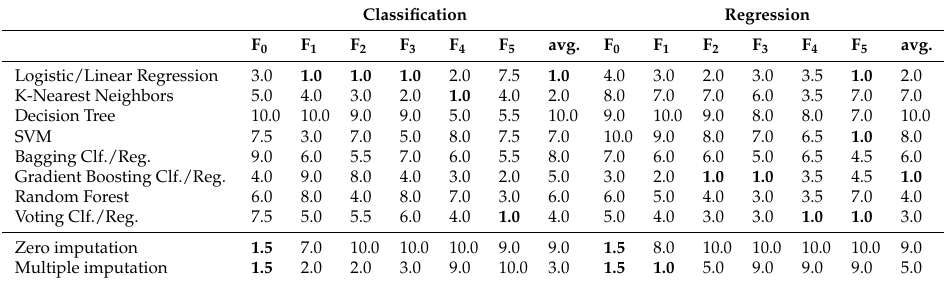
Table 10. Rankings of classification and regression models for different feature sets for protein.